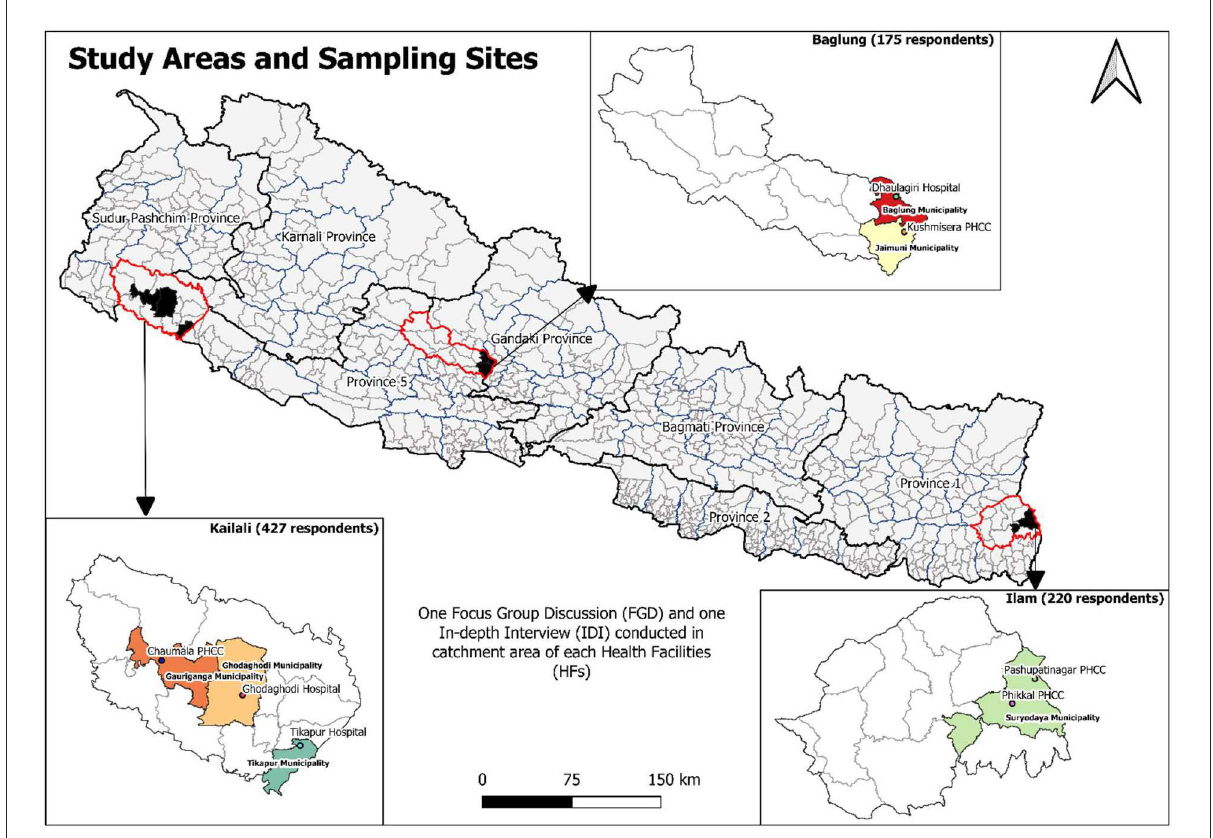
FIGURE1 Map of the study clusters with number of